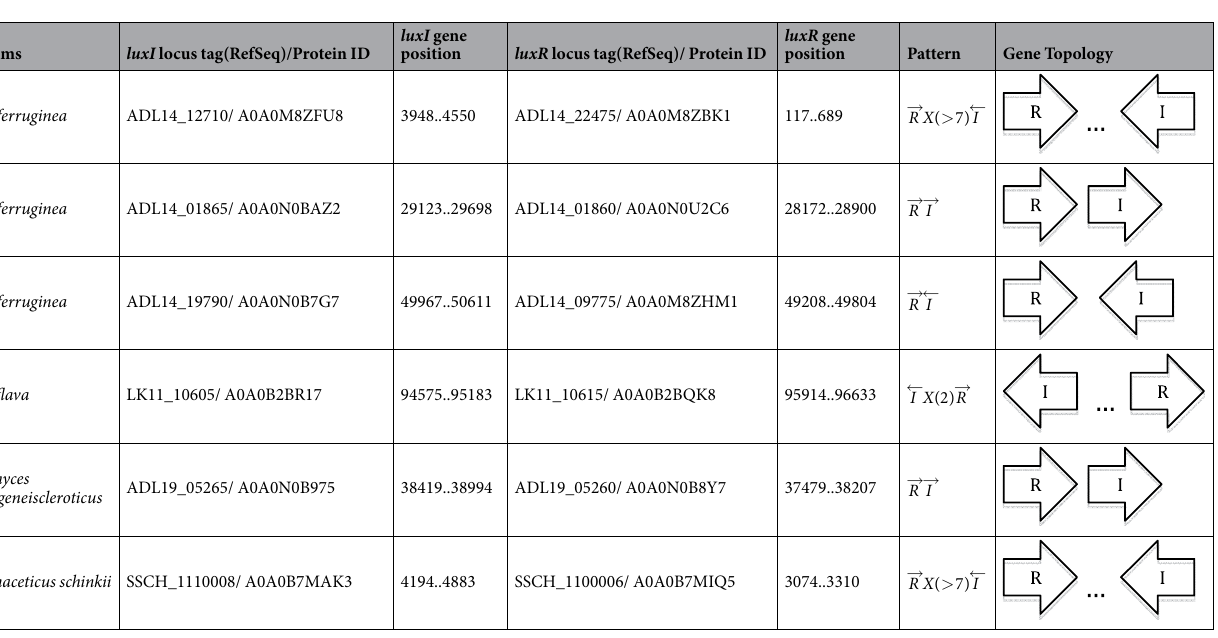
Table 1. Topological arrangements of canonical luxI/luxR genes in Gram-positive